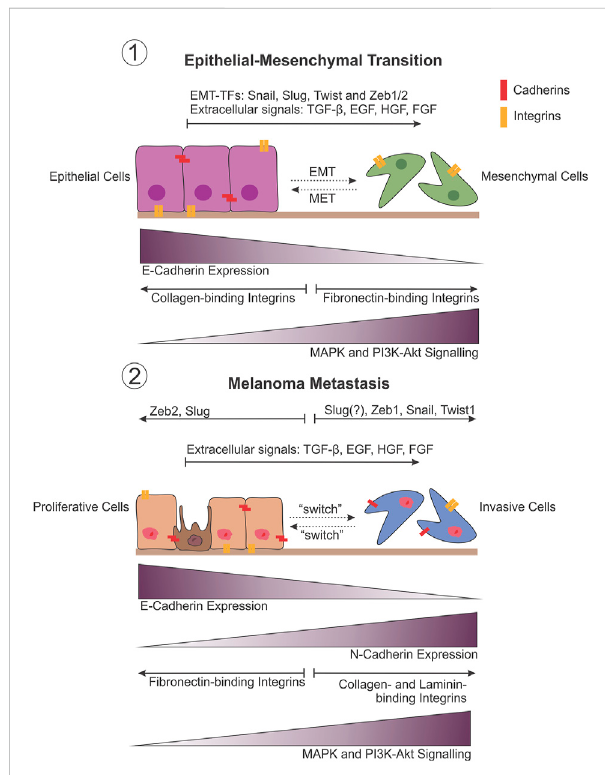
FIGURE 2 Comparison between EMT and melanoma metastasis. Phenotypic plasticity observed during melanoma metastasis draws striking similarities with the changes that occur during epithelial- mesenchymal transition (EMT)(1).This is believed to be theresult of the developmental lineage of melanocytes in the neural crest, allowing melanoma cells to undergo an EMT-like transition to facilitate metastasis by varying the expression of adhesion molecules in particular, in response to shifts in transcriptional regulation (EMT- TFs)